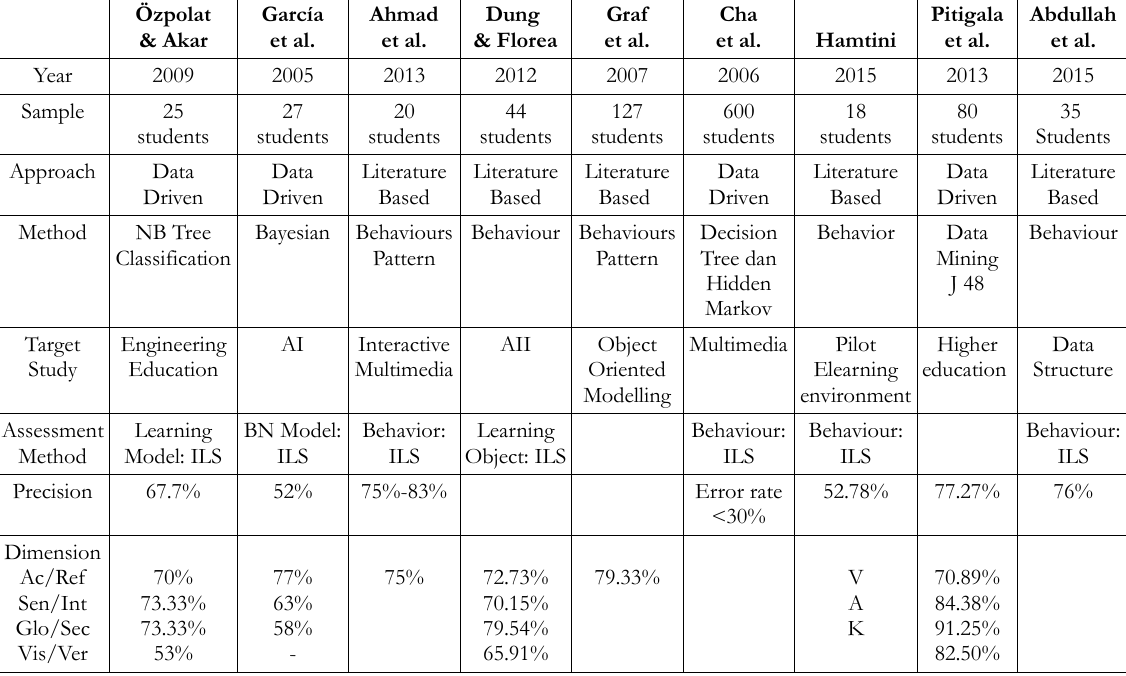
Table 1. Comparison of previous